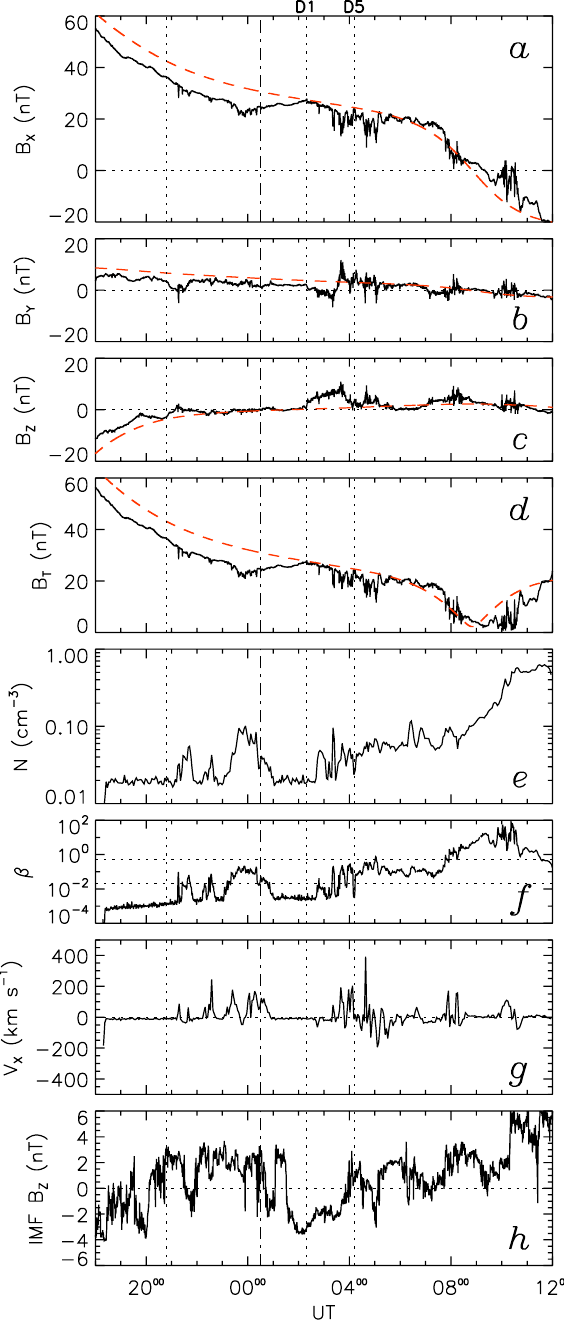
Fig. 2. Observations from Cluster-1 for the interval 18:00– 12:00 UT, 28–29 August 2004. (a)–(d) B x , B y , B z , and B T compo- nents of the magnetic field in GSM coordinates. Red dashed curves show T96 field predictions. (e) and (f) Ion density and V x compo- nent of the ion velocity from CIS/HIA. (g) IMF B z as measured by ACE, lagged to the